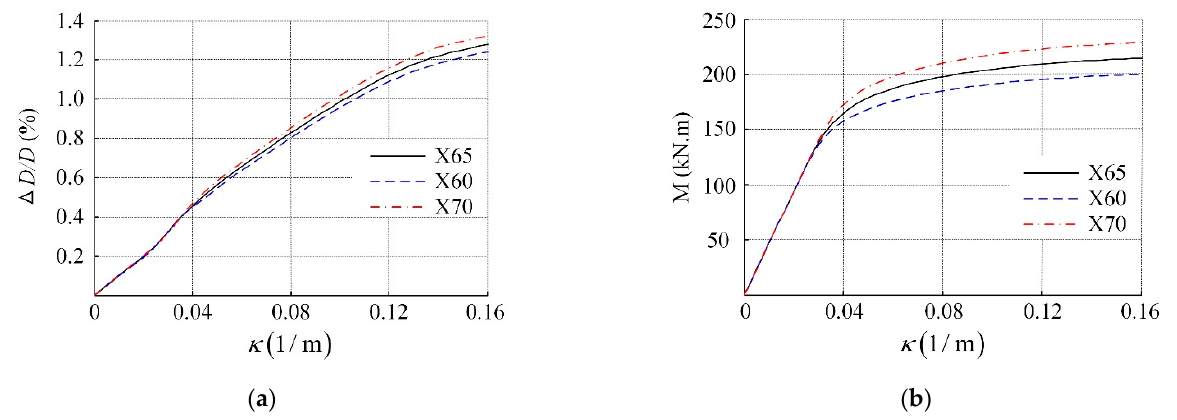
Figure 16. Effect of yield strength on ovalization and bending moment during pipe reeling: ( a ) variation of ovalization with curvature, ( b ) variation of bending moment with curvature.